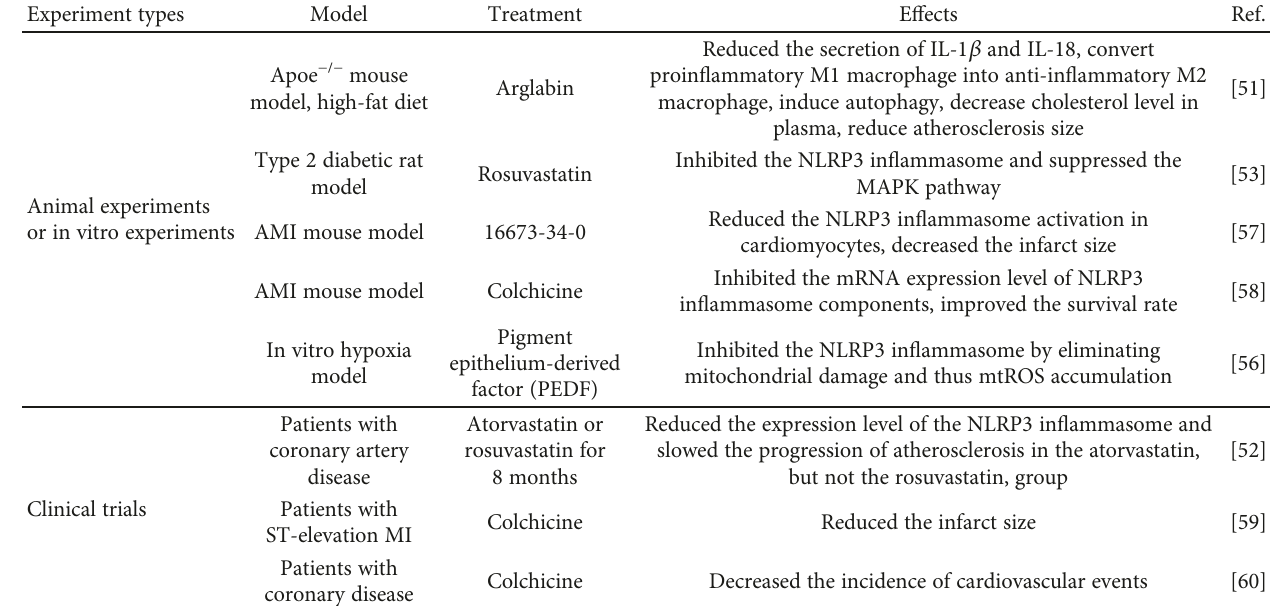
Table 1: Possible therapeutic approaches targeting the NLRP3 in fl